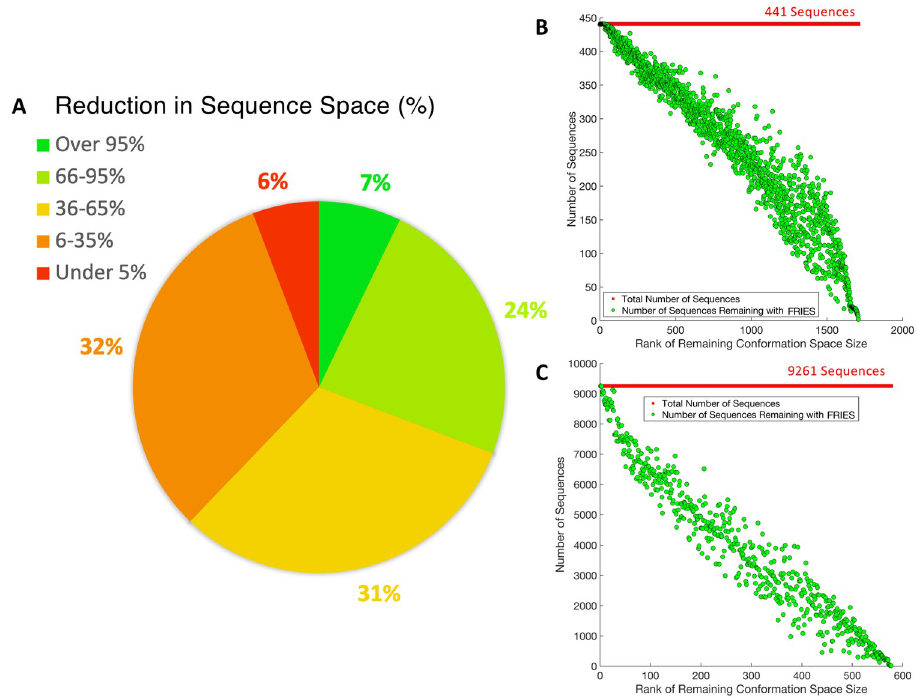
Fig 3. Reduction in input sequence space size using FRIES . (A) A pie chart representing the reduction in the sequence space in percentages across all 2,662 designs. 7% of the designs had a reduction in sequence space over 95%, 24% of the designs had a reduction in sequence space between 66-95%, 31% of the designs had a reduction in sequence space between 36-65%, 32% of the designs had a reduction in sequence space between 6-35%, and 6% of the designs had a reduction in sequence space under 5%. (B) and (C) plot the number of sequences remaining after using FRIES starting with 441 and 9,261 sequences total, respectively. The number of sequences remaining for each design are sorted in order of decreasing size of the remaining conformation space after FRIES